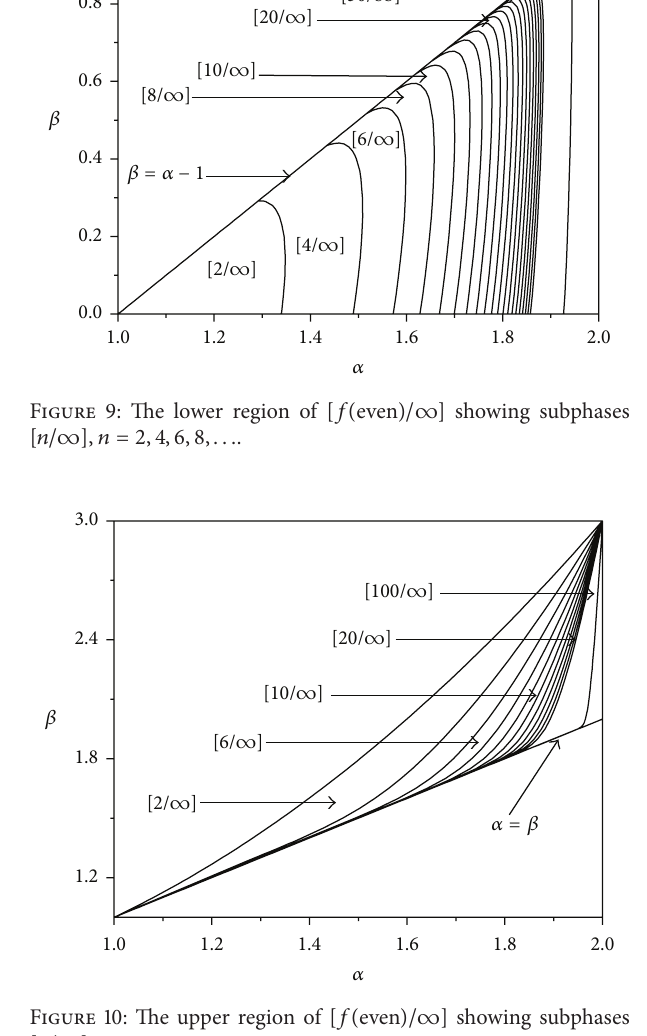
Figure 10: The upper region of [ 𝑓( even )/∞ ] showing subphases [ 𝑛/∞ ], 𝑛 = 2, 3, 4,6, . ..